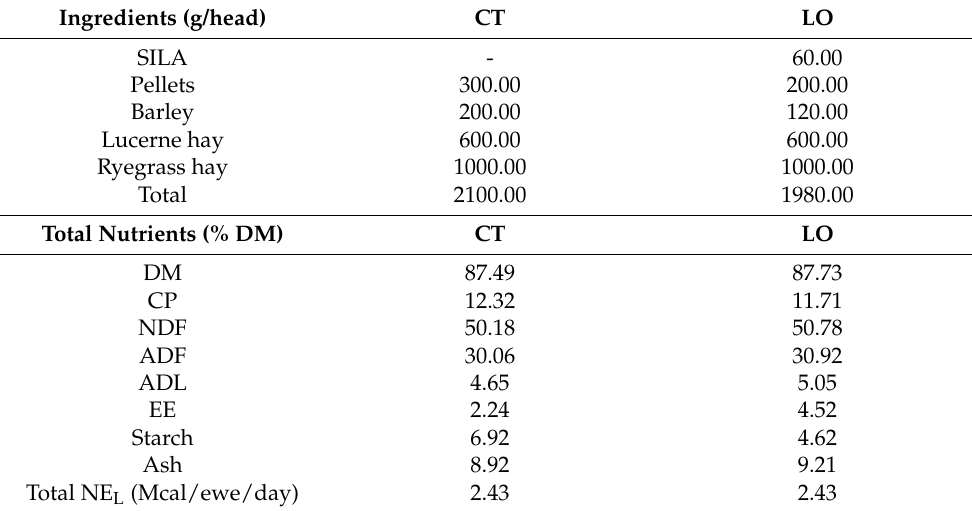
Table 1. Ingredients and chemical composition of diets fed to Sarda dairy ewes: non-supplemented (CT) and supplemented with bypass linseed oil